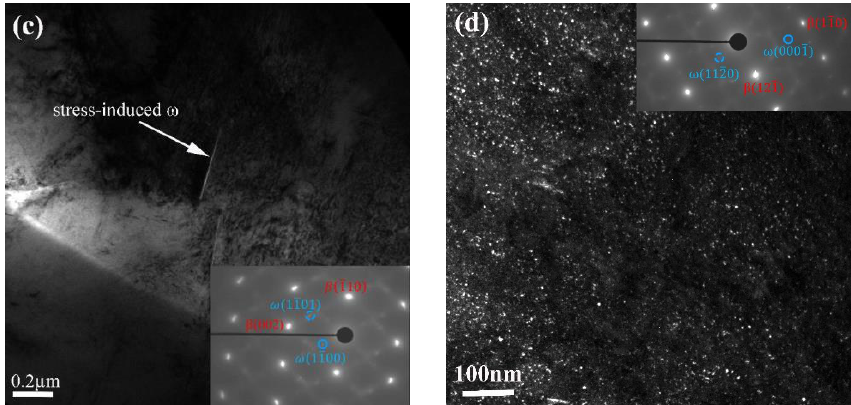
Figure 5. ( a ) Bright field image revealing continuous slip bands in the β matrix. ( b ) Dark field (DF) image showing the presence of stress- induced α” martensite obtained using the reflection in dashed yellow circle in the inset (Zone axis: [ 1̅13 ] β ‖[002] α” ). ( c ) DF image revealing stress- induced ω taken using the reflection in dashed blue circle in the inset (Zone axis: [110] β ǁ [ 112̅0 ] ω ). ( d ) DF image displaying ω ath precipitation, which is taken using dashed blue circle in the inset (Zone axis: [ 113 ] β ǁ [ 1̅100 ] ω ).